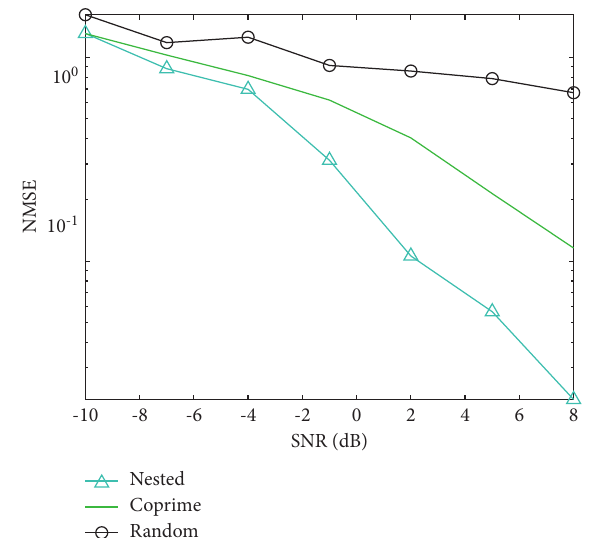
Figure 3: NMSE comparison of three different antenna selection